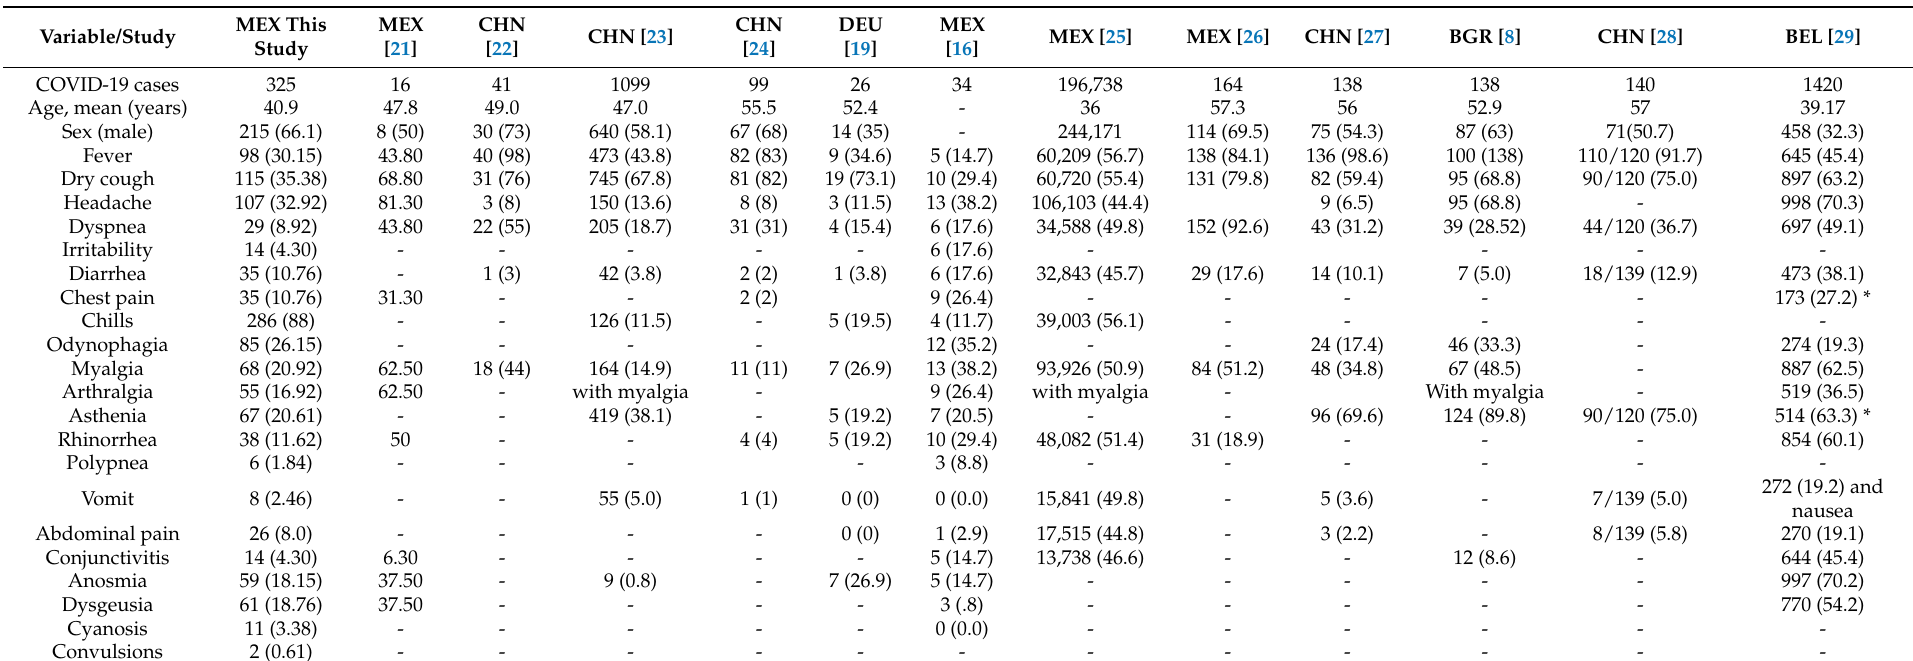
Table 5. Comparison of COVID-19-related